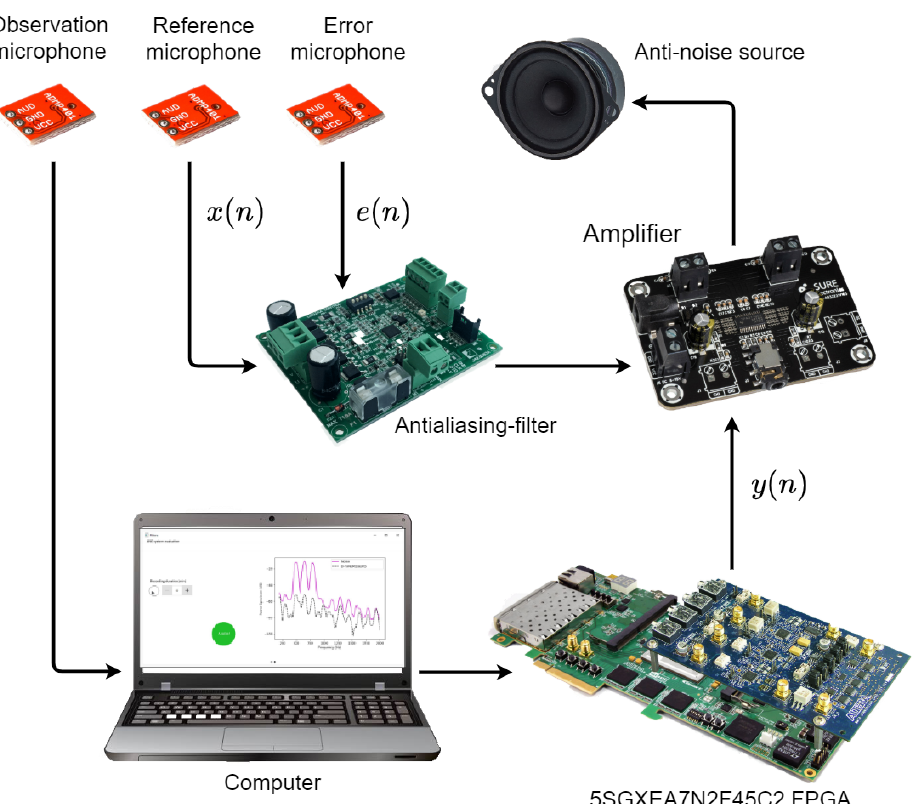
Figure 10. Components of the ANC system.